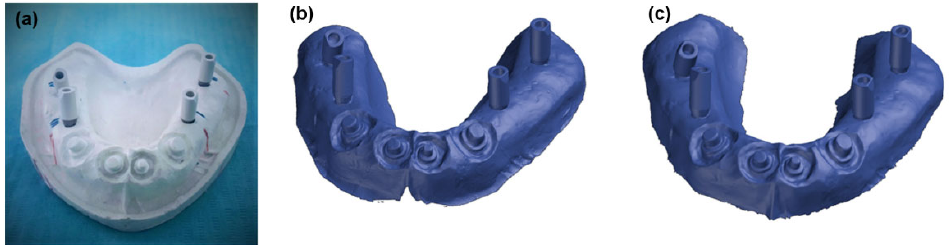
Figure 3. Showing ( a ) master model with screw-secured scan bodies, and the corresponding 3D reference models reconstructed by ( b ) Identica Blue and ( c ) D900L 3D scanners.